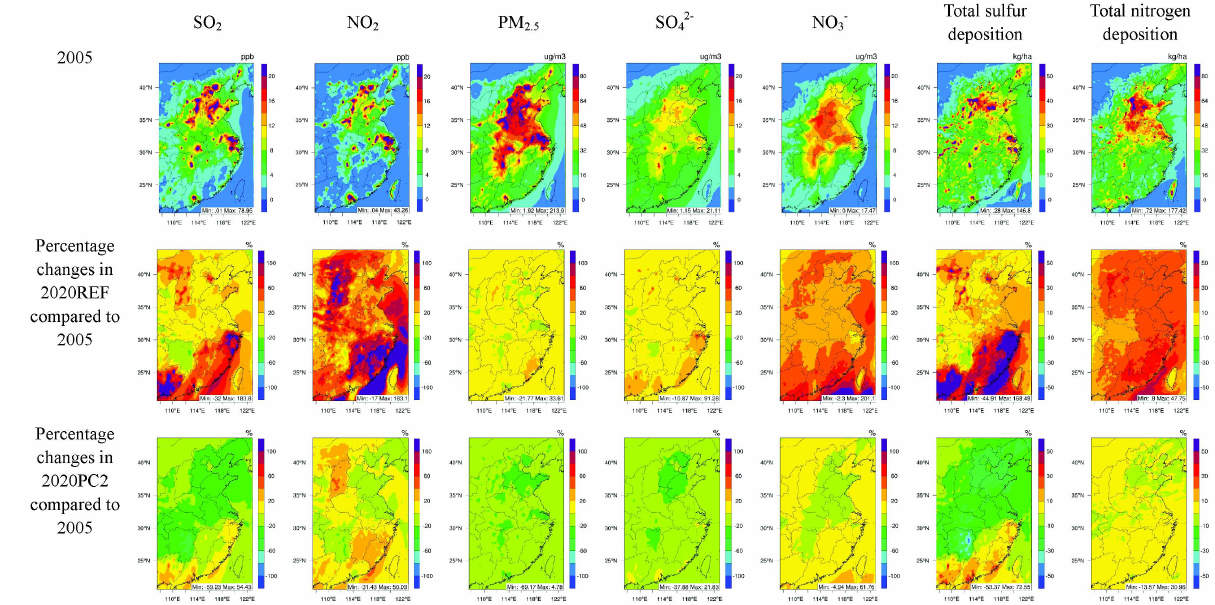
Fig. 5. Spatial changes of SO 2 , NO 2 , PM 2 . 5 concentration and total sulfur and nitrogen deposition in 2020 (4-month mean).